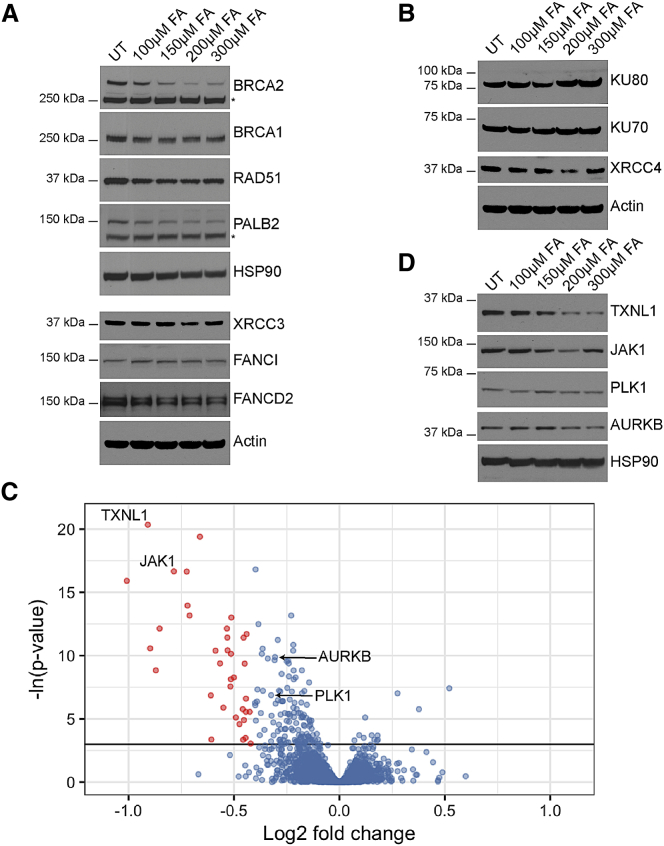
Formaldehyde Selectively Depletes Components of the Cellular Proteome(A) Abundance of proteins involved in homologous recombination or the Fanconi anemia repair pathway in wild-type HeLa Kyoto cells treated with FA for 5 hr.(B) Abundance of proteins involved in non-homologous end-joining in HeLa Kyoto cells treated with FA for 5 hr.(C) Volcano plot showing the results of the SWATH-MS analysis of HeLa Kyoto cells treated with or without 200 μM FA for 5 hr. Each dot represents a protein with Benjamini-Hochberg adjusted p values plotted along the y axis, and the fold change in abundance following FA treatment along the x axis. The horizontal black line indicates where p = 0.05. Red dots mark proteins that are depleted by ≥25% compared to untreated controls in a statistically significant manner (p < 0.05). Proteins tested by western blotting are labeled.(D) Abundance of selected proteins from SWATH-MS analysis in HeLa Kyoto cells treated with FA for 5 hr.See also Figure S4 and Tables S1 and S2.